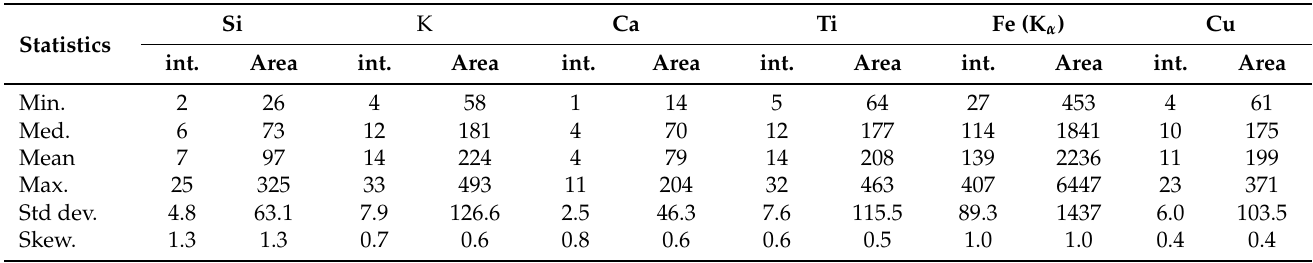
Table 2. Statistical description of the mean elemental peak intensity and area (in keV) for 108 soil